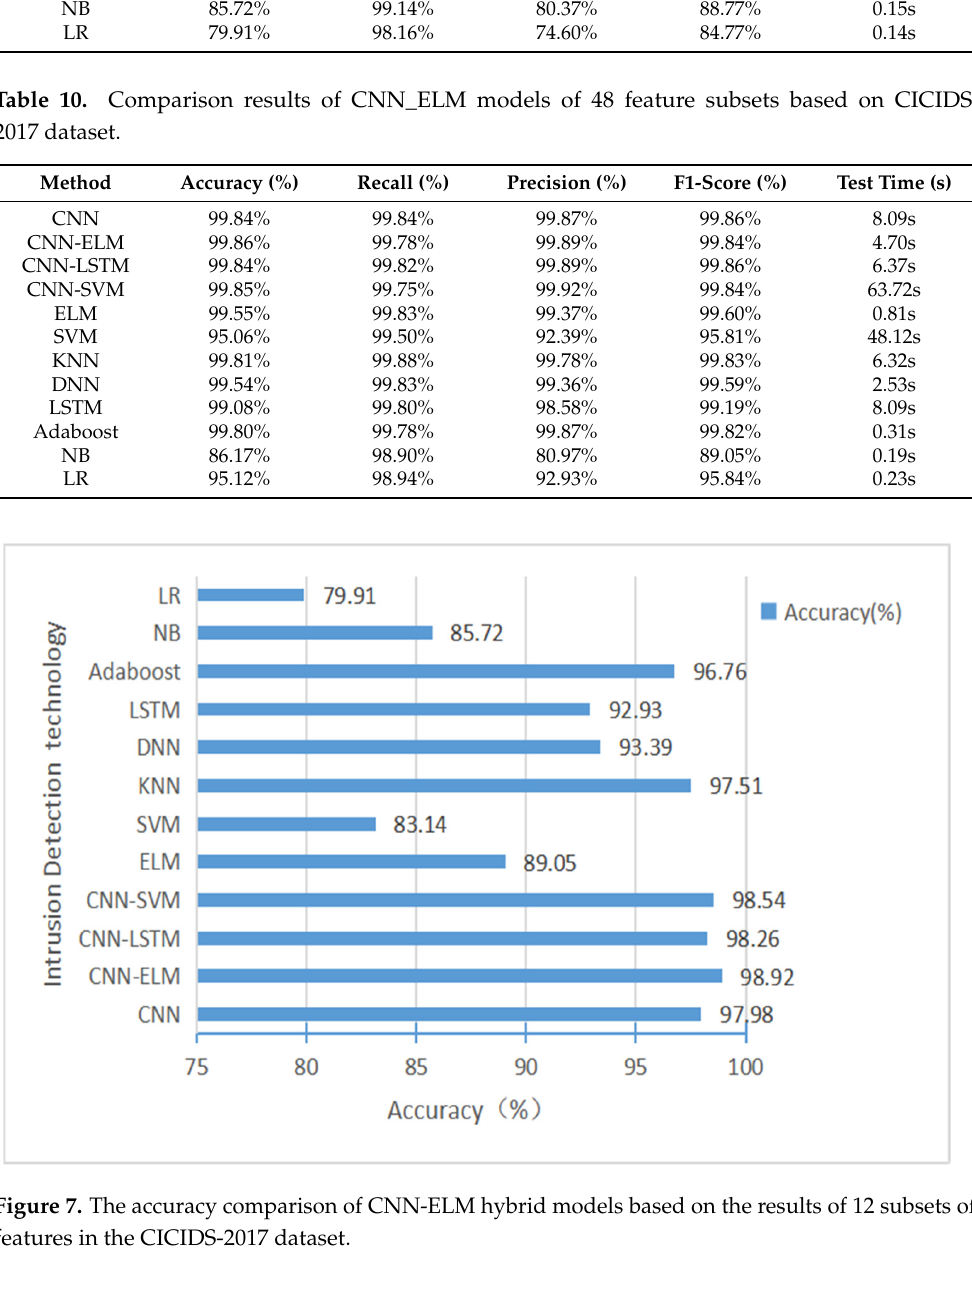
Figure 8. The accuracy comparison of CNN-ELM hybrid model based on the results of 48 subsets of features in the CIC-IDS 2017 dataset As can be seen from Tables 9 and 10, the results for accuracy, recall, precision, and F1-score of the resulting CNN-ELM hybrid model outperformed the other machine learn- ing models, both for the 12-feature subset and the 48-feature subset. In Table 10, although